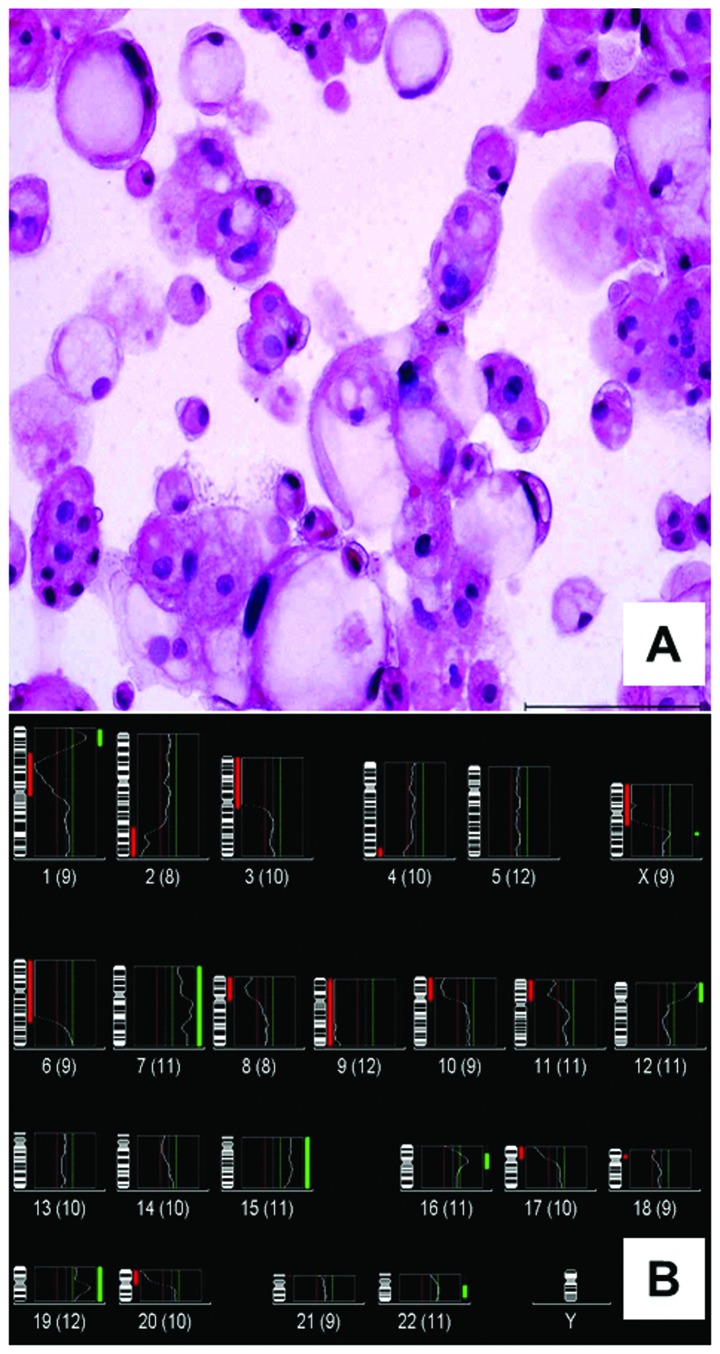
(A) Cytology of the U-CH2 chordoma cell line. (B) CGH analysis of U-CH2. The gains are given in green, the losses in red.